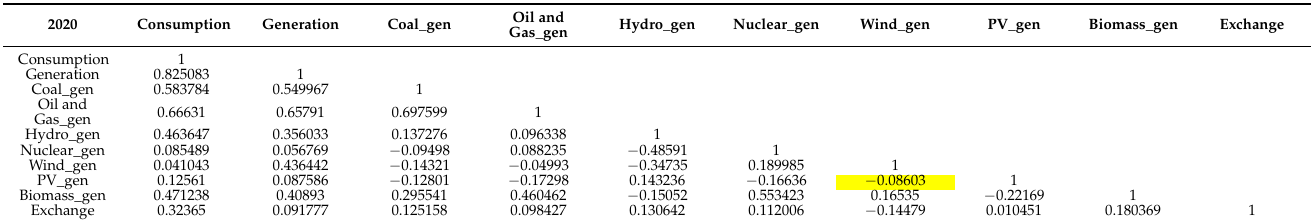
Table 2. Correlation coefficients between consumption and generation sources in 2020.